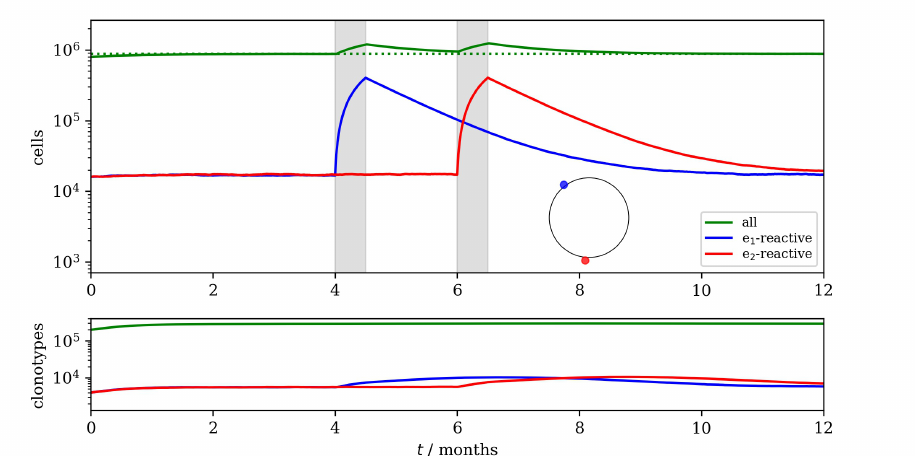
Figure 14. Two infection episodes: different viral epitopes. The blue and red dots on the circle indicate the locations of the two different viral epitopes considered, e 1 (blue) and e 2 (red). The two shaded intervals indicate infection with epitopes e 1 and e 2 , respectively. Top: The total number of cells is shown in green. The blue and red lines show the numbers of cells recognizing e 1 and cells recognizing e 2 , respectively. Bottom: The total number of surviving clonotypes as a function of time is shown in green. The blue and red lines show the numbers of surviving clonotypes recognizing e 1 , and of surviving clonotypes recognizing e 2 , respectively. Parameter values were: µ = 1 month − 1 ,